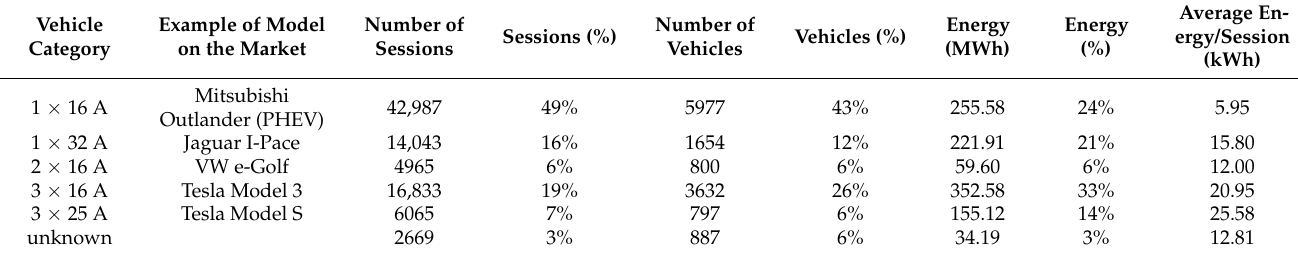
Table 1. An overview of the inferred EV categories with examples of corresponding popular models on the market and the distribution on over several indicators on Flexpower stations (November 2019 to March 2020). Vehicle